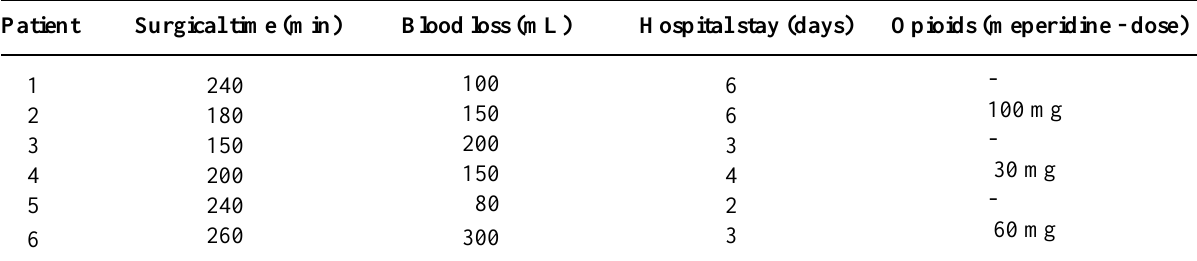
Table 2 – Trans- and post-operative parameters of the present series.